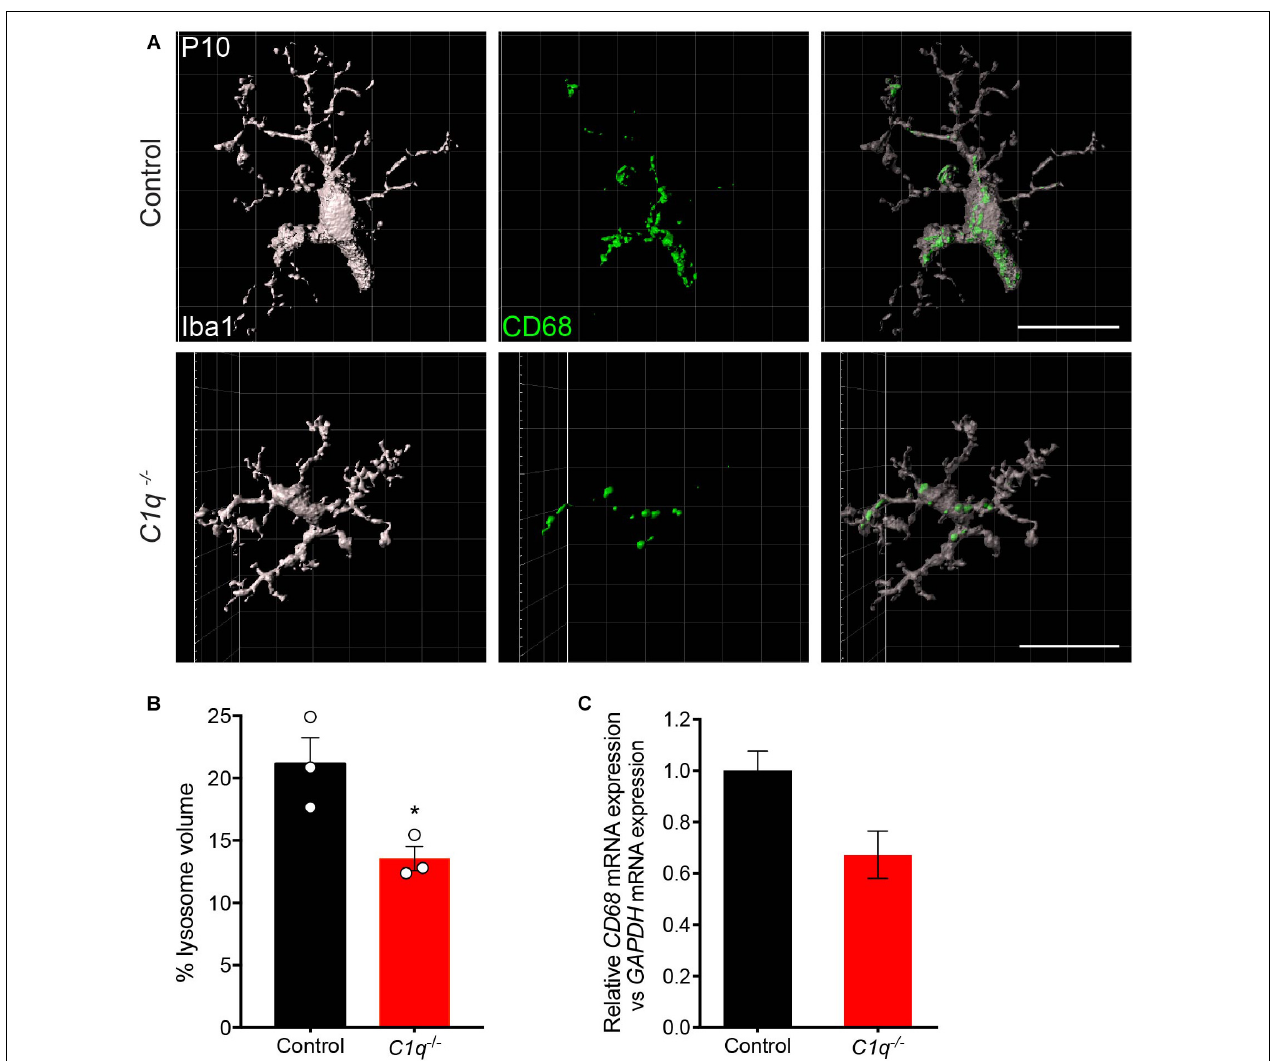
FIGURE 4 | Loss of C1q leads to decreased microglia activation. (A,B) Retinas from C1q − / − and wild type control mice at P10 were stained for microglia (Iba1, gray) and the lysosome marker CD68 (green). Outer retina microglia were reconstructed (A) and used to quantify the relative lysosomal volume within individual cells (B) . Microglia from C1q − / − mice show a significant decrease in CD68-positive lysosomal volume relative to controls. (C) The levels of CD68 mRNA were quantified in wild type control and C1q − / − mice using qRT-PCR and normalized to GAPDH . CD68 mRNA levels trended lower but were not significantly different. N = 3 control and N = 3 C1q − / − mice. Scale bars = 25 µ m. Data are represented as the mean ± SEM. * p < 0.05 using unpaired two-tailed Student’s t